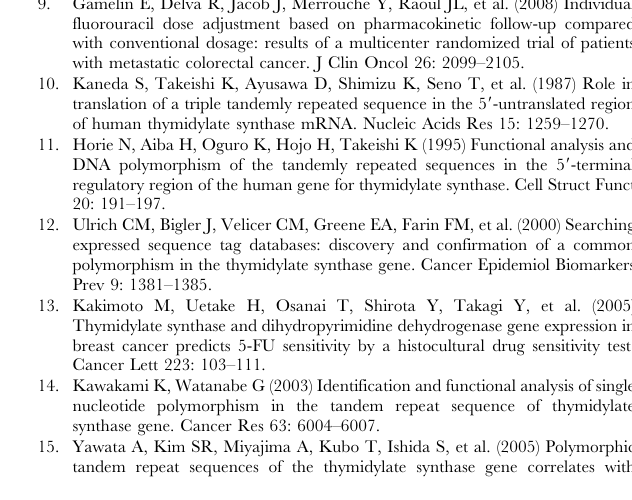
Figure S1 Structure of the TYMS genetic region. The structure of the TYMS genetic region from coordinates 654,843– 657,842 (UCSC genomic build GRCh37/hg19) is shown. The mononucleotide repeats (MR) and VNTR appear as bold underlined letters. The coordinates of the MR are reported in Table 2. The TYMS promoter is in italics. The primers used to amplify the MR are listed. Figure S2 Enlarged version of figure 1B (in main document). Nine haplotype blocks (in triangular shape) were obtained by haplotype analysis using Haploview (see Materials and Methods), covering the 80 kb TYMS genetic region (depicted in Figure 1A). The reference SNP numbers (rs) are shown on top.